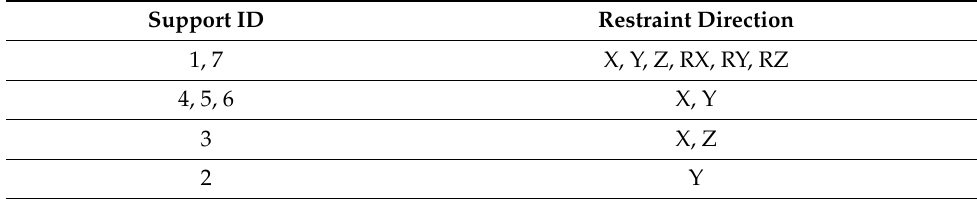
Table 3. Boundary condition of the piping system.